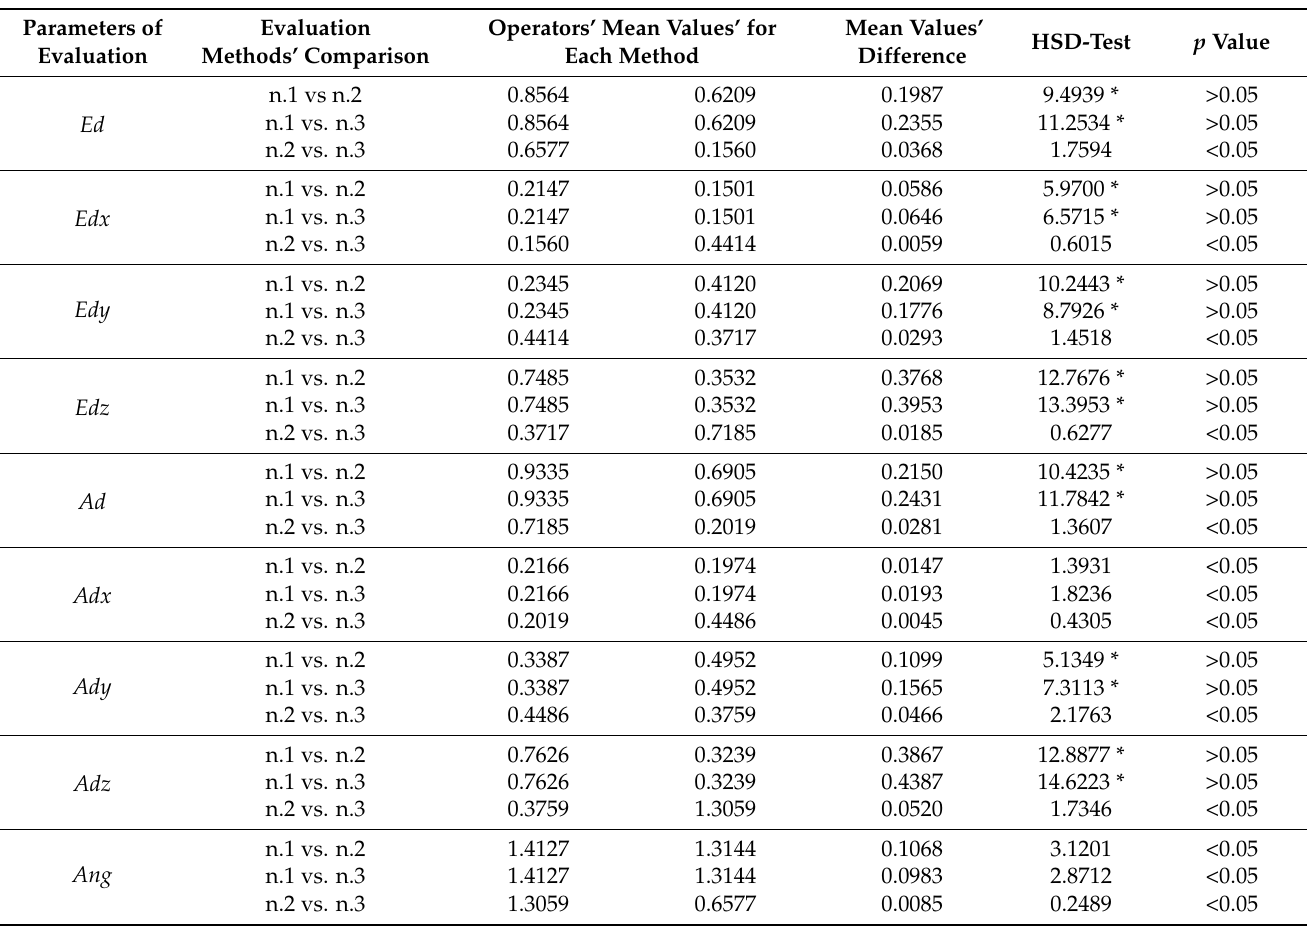
Table 3. Pairwise ANOVA analysis (Tukey HSD test) correlating the single dependent variables mean results from the two operators for each evaluation method.